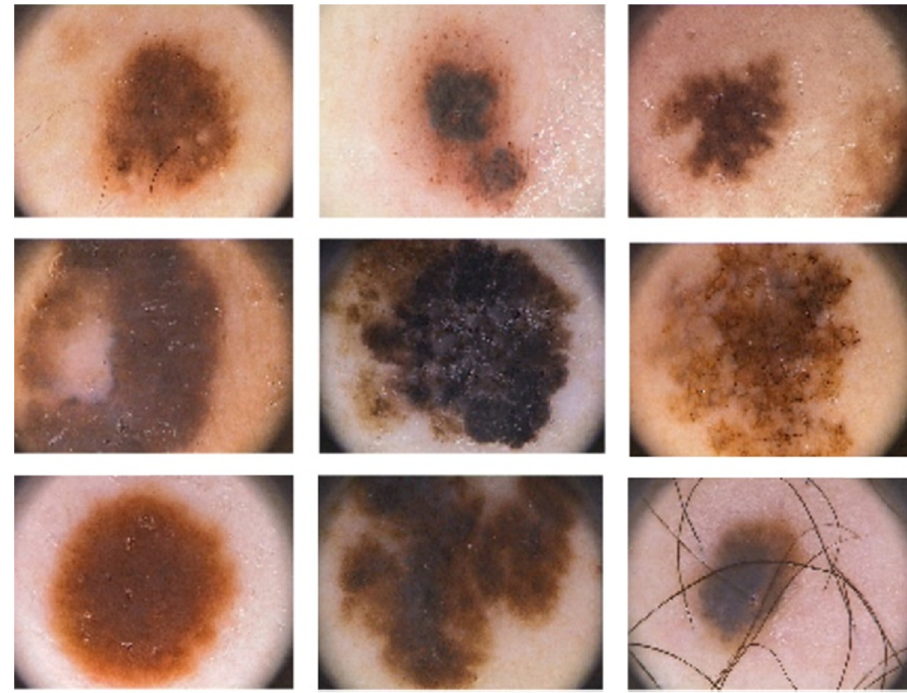
Figure 1: Some samples of the PH 2 dataset in this